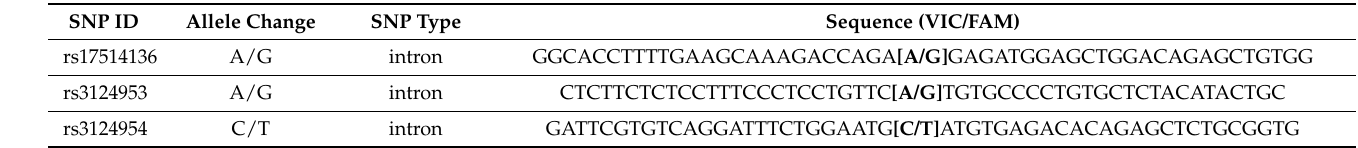
Table 1. Polymorphisms and primers used in genotyping